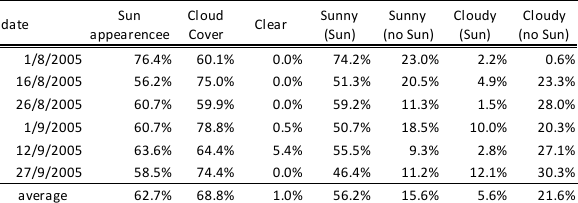
Table 1. The weather conditions of the objective six days. (Sun) and (no Sun) mean the Sun appearance or hiding by